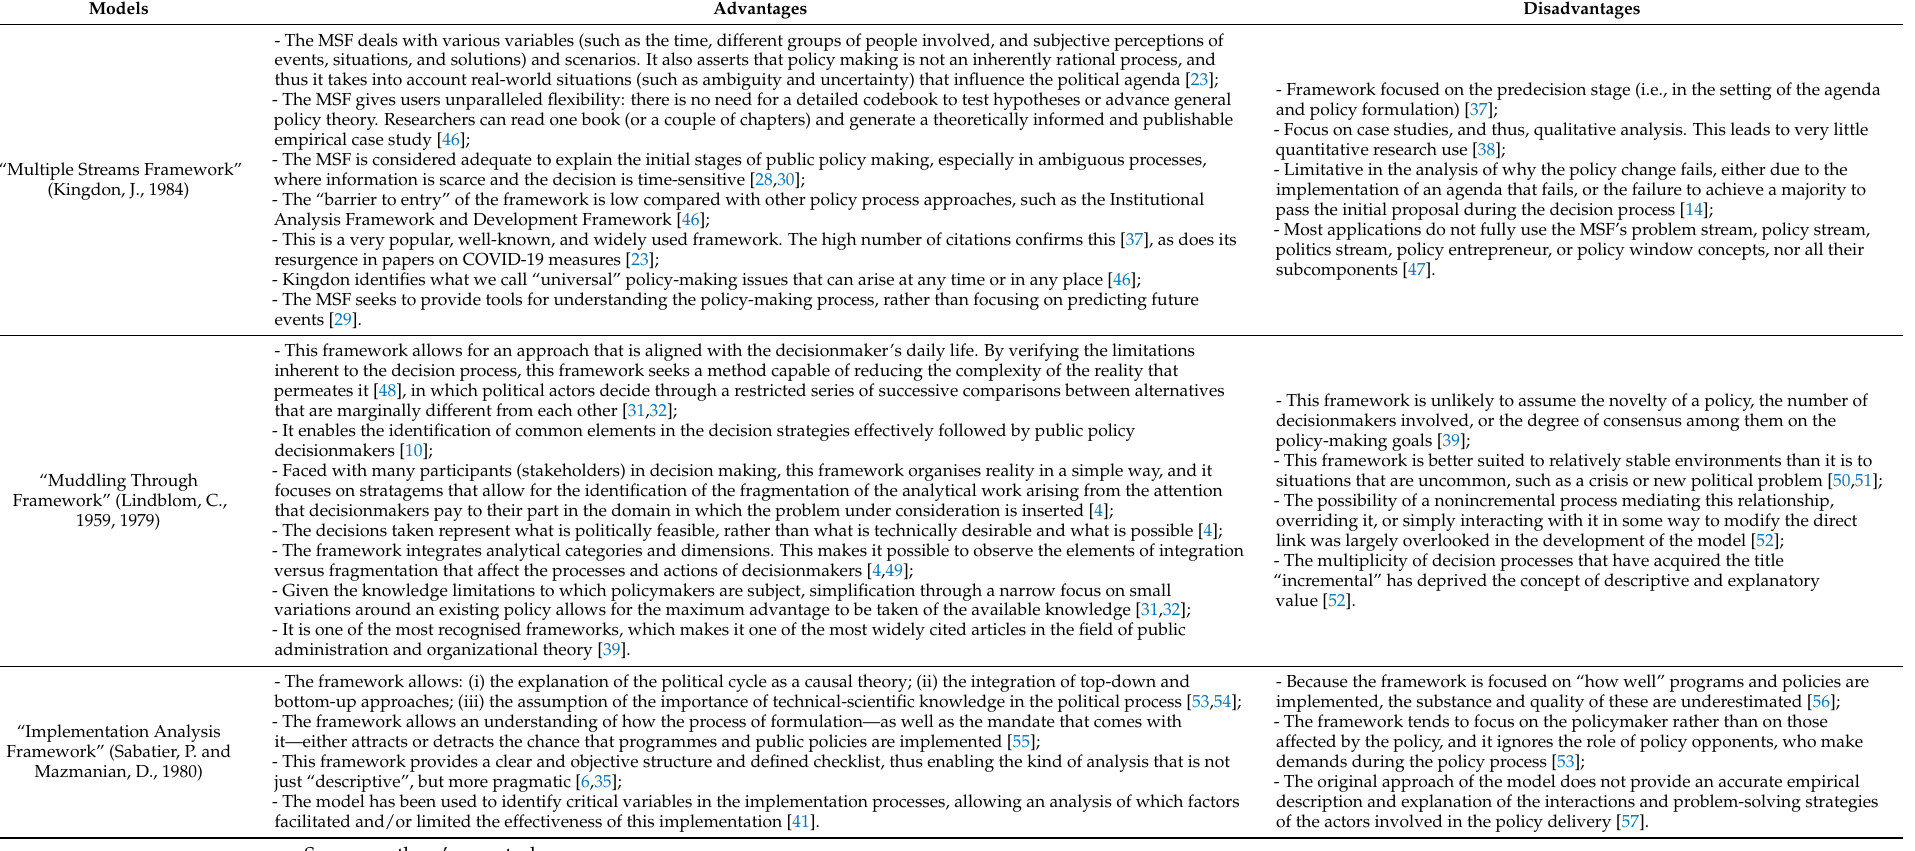
Table 4. Summary of the Advantages and Disadvantages of each Framework or